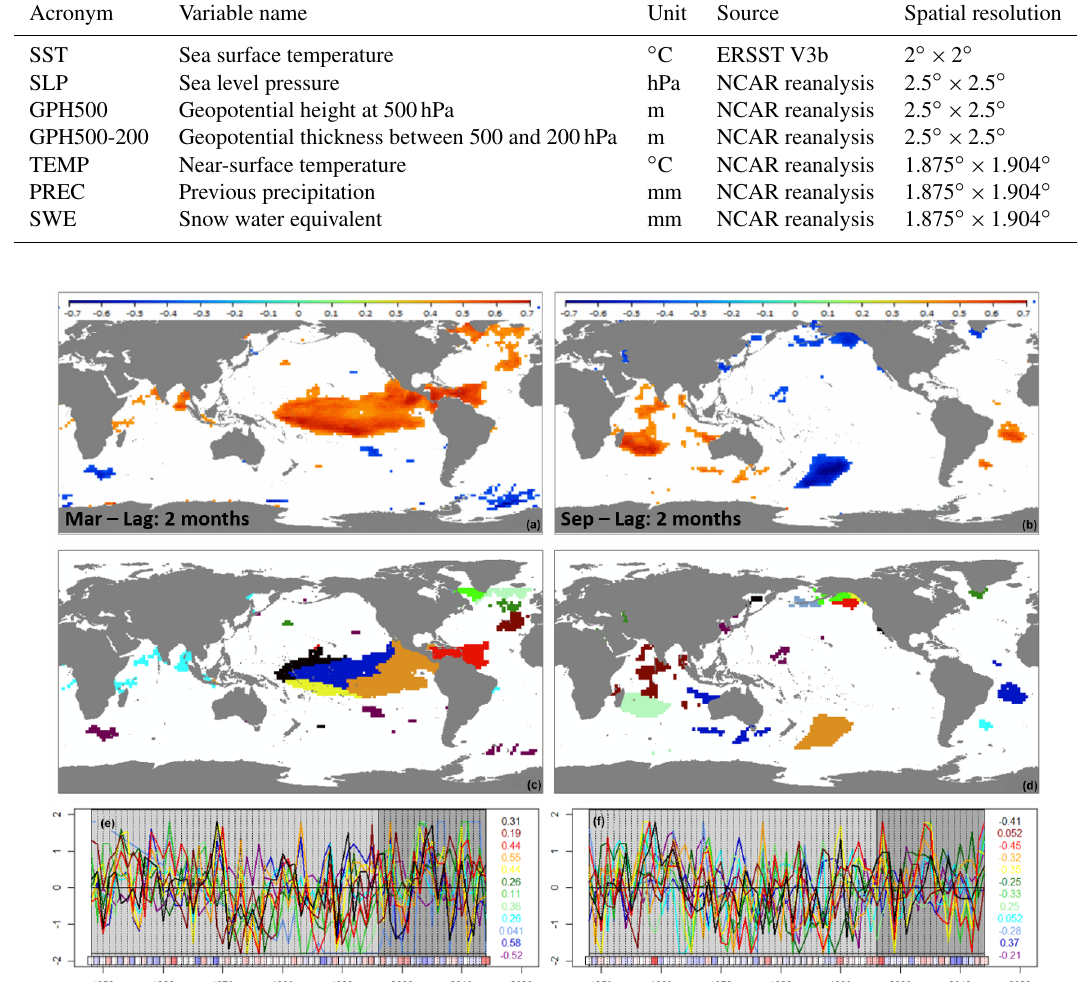
Table 1. Globally gridded variables utilized as potential predictor variables by the statistical forecast model.